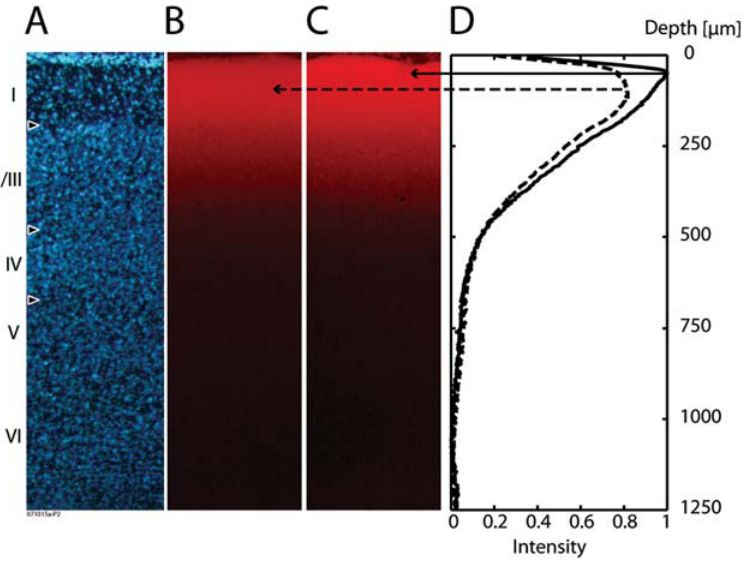
Figure 6. Depth profile of voltage-sensitive dye signal changes with bleaching. Stained cortex was ‘‘bleached’’ for 2000 seconds, with part of the cortex protected from bleaching by a piece of aluminum foil. A. Histoarchitectonic profile of the cortex with DAPI counterstain. B. Dye profile of bleached cortex. Staining with voltage-sensitive dye RH 1691 is shown. C. Dye profile of a cortical area protected from bleaching. An overall decrease in fluorescence is evident in bleached cortex (B) compared to protected cortex (C). D. Depth intensity profile of protected cortex (solid line) and bleached cortex (dotted line) are displayed, and show a slight shift in the center of the fluorescence distribution in the deeper direction, with bleaching.